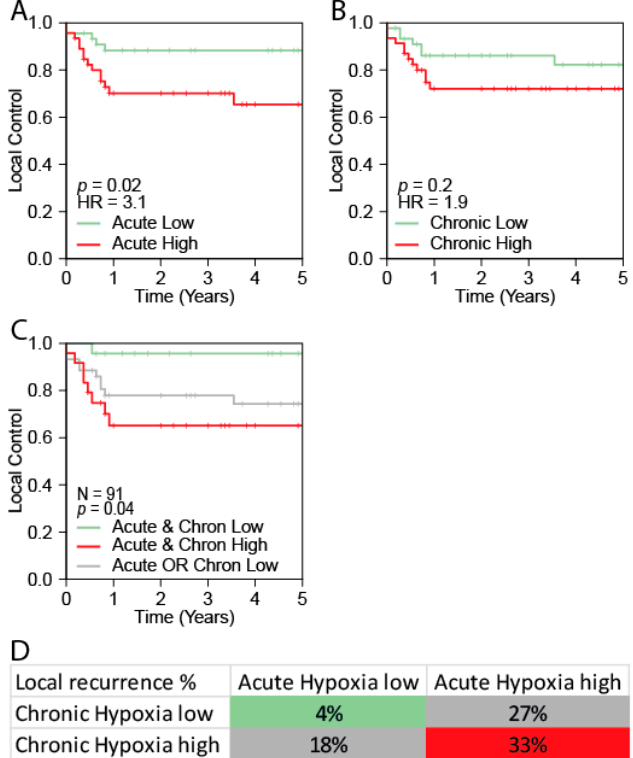
Figure 3. Combined acute and chronic hypoxia scores. ( A ) Kaplan–Meier curve showing local control of the “High” versus “Low” groups of the acute hypoxia profile. ( B ) Kaplan–Meier curve showing local control of the “High” versus “Low” groups of the chronic hypoxia profile. ( C ) Kaplan–Meier curve showing local control for 3 groups: (1) acute and chronic hypoxia both low, (2) acute or chronic hypoxia high, or (3) acute and chronic hypoxia both high. The crosstab shows the percent of local recurrences per subgroup in 91 chemoradiotherapy patients. Samples were divided into two groups using the median. Cells are colored in a color corresponding with the line color in the Kaplan–Meier curve. P-value represent the log-rank p -value. ( D ) Crosstab showing the percentage local recurrences per